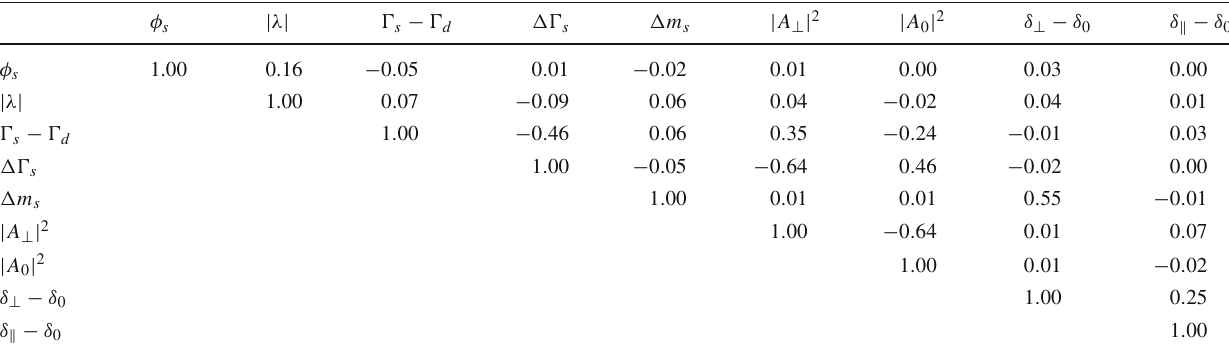
Fig. 11 Decay-time and helicity-angle distributions for background subtracted B 0 s → J /ψ K + K − decays (data points) with the one- dimensional projections of the PDF at the maximum-likelihood point. The solid blue line shows the total signal contribution, which contains Table 5 Correlation matrix including the statistical and systematic correlations between the